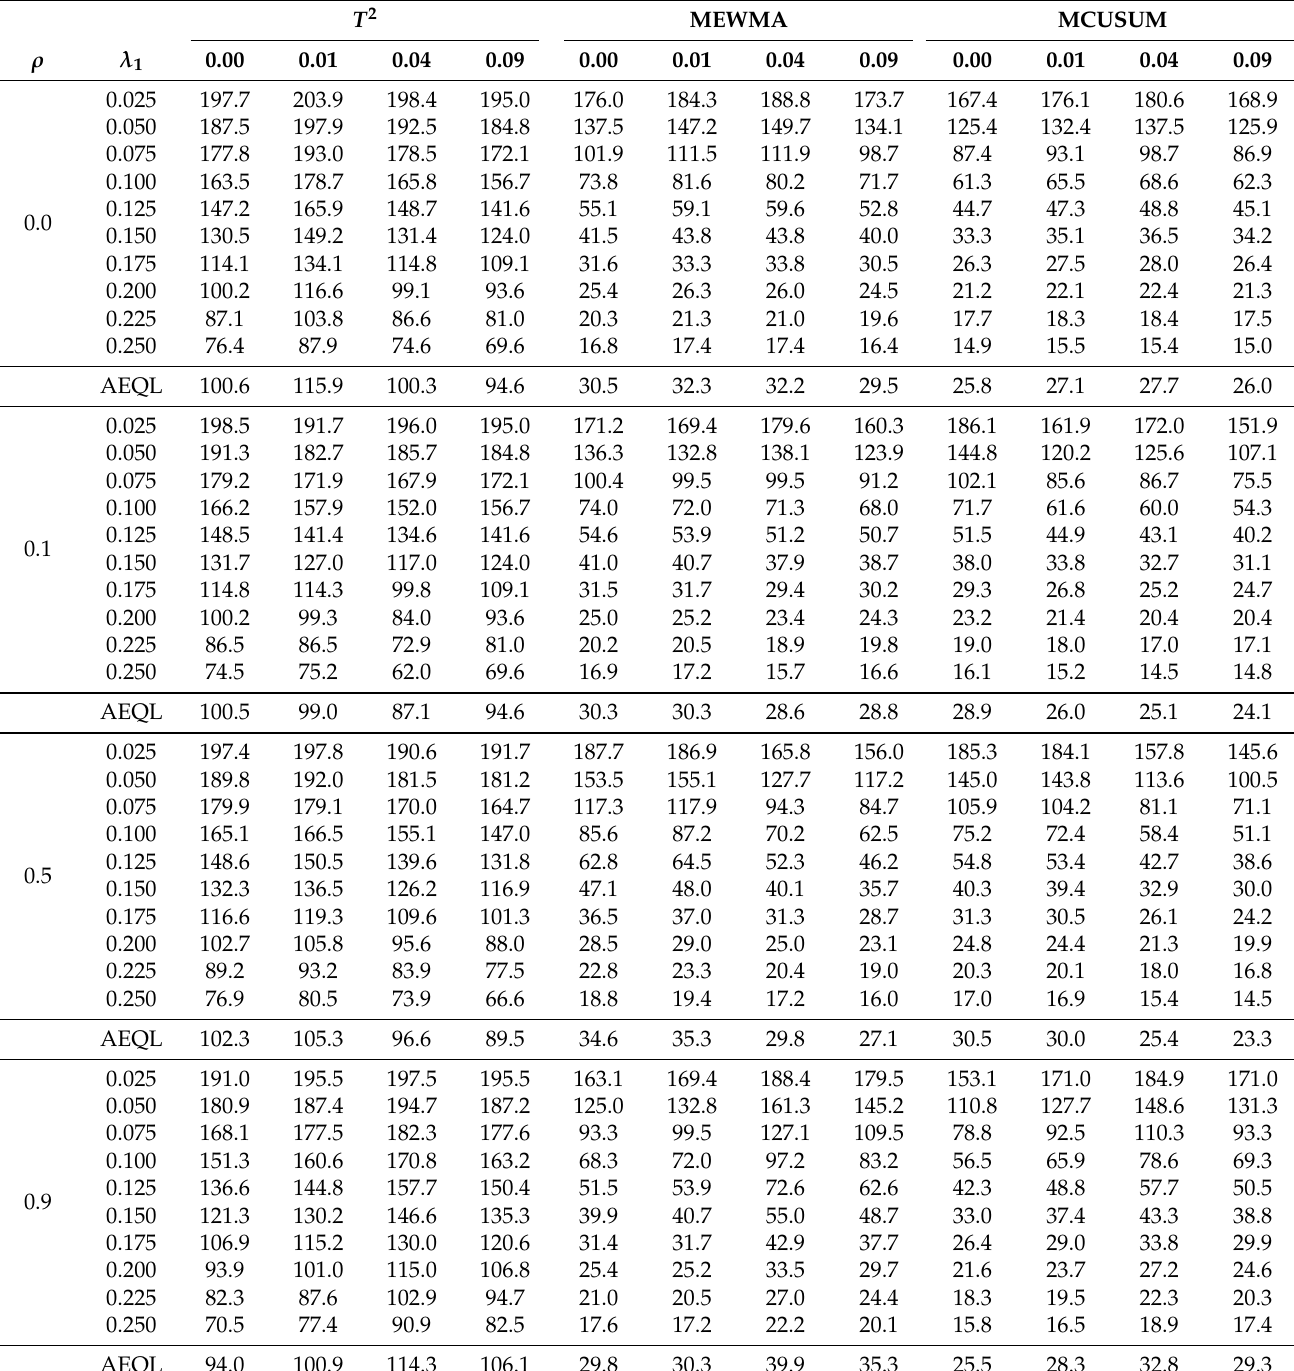
and ρ under λ 1 σ in δ